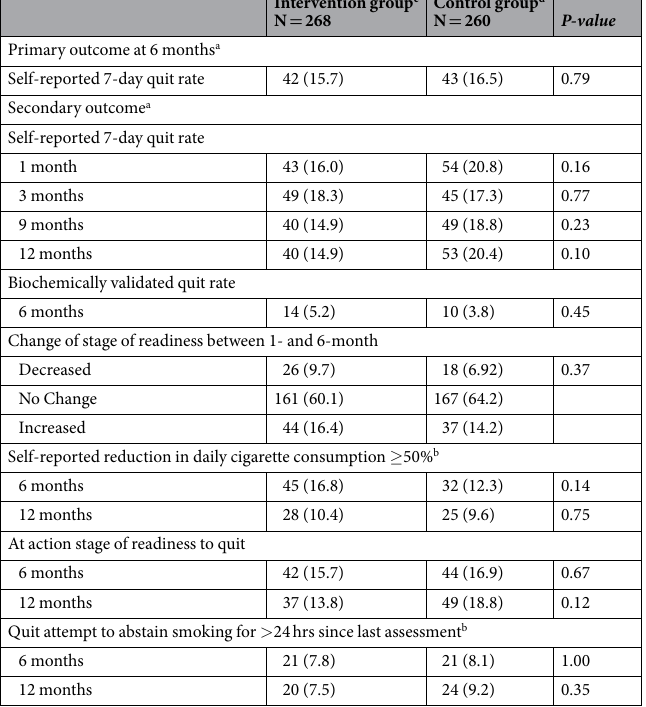
Table 2. Quit rate, smoking reduction rates and quit attempts in intervention and control groups a By intention- to-treat analysis: assume all non-responded follow-up patients as current smokers, who did not make a quit attempt over the period and did not change their behavior compared to baseline. b Quitters excluded from numerator. c Brief advice based on risk communication. d Usual